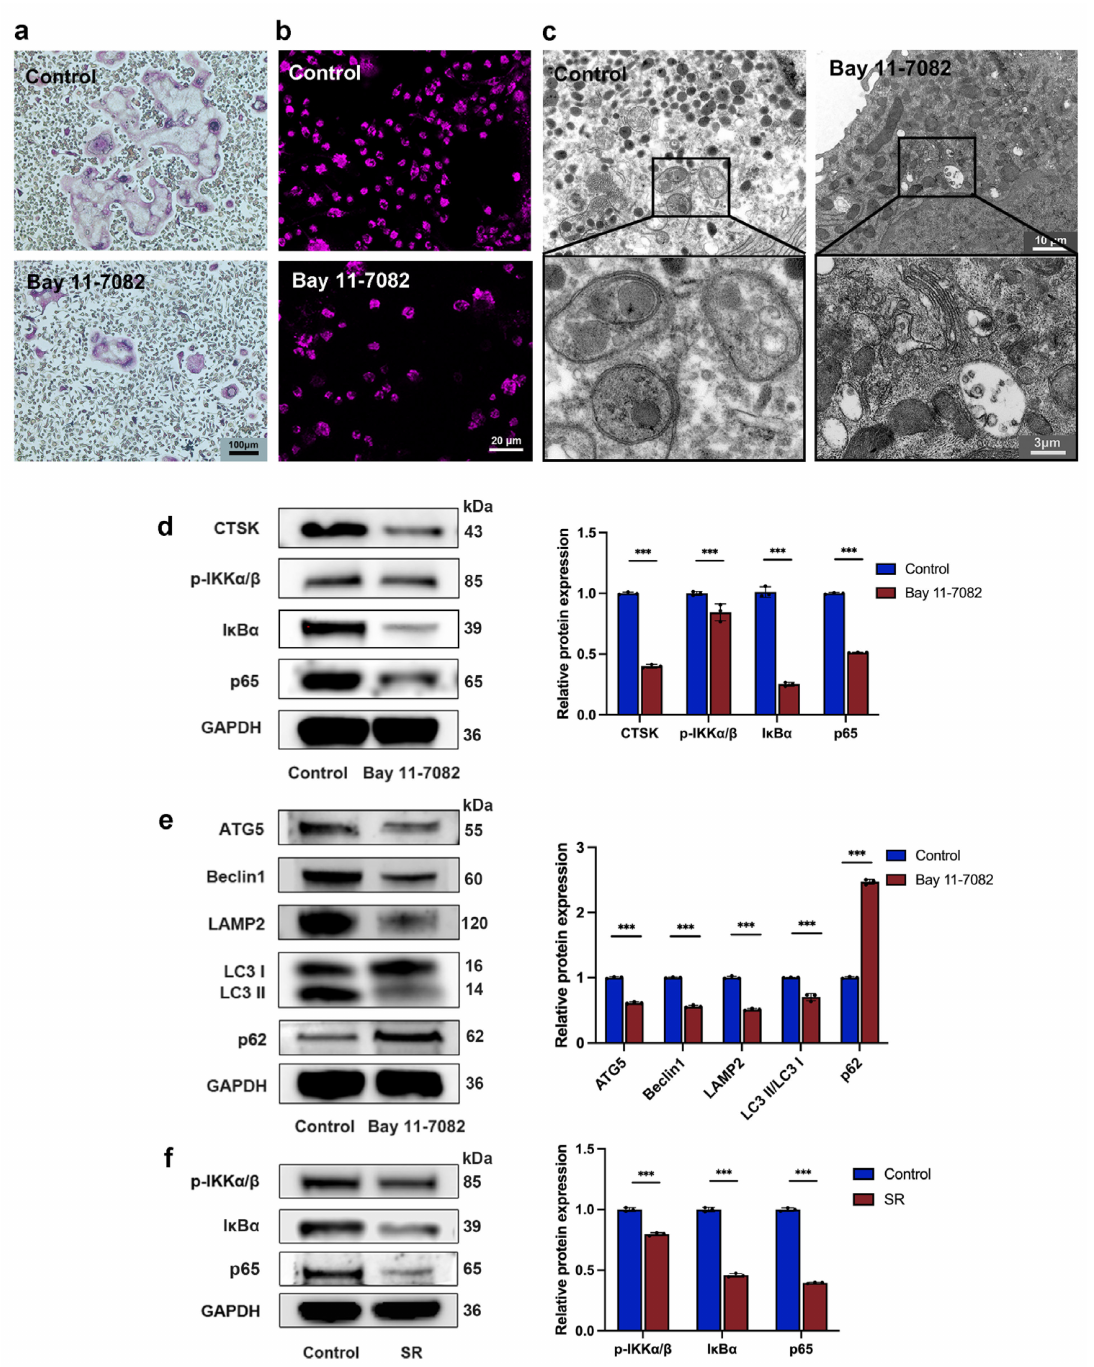
Figure 2. Strontium ranelate inhibited osteoclast differentiation through NF- κ B-pathway-dependent autophagy in vitro. ( a ) TRAP staining images after pre-osteoclasts received different treatments for 5 days. ( b ) Monodansylcadaverine staining images after pre-osteoclasts received different treatments for 5 days. ( c ) Representative images of autophagosomes captured with a transmission electron microscope after pre-osteoclasts received different treatments for 5 days. Western blot assay and relative protein expression of the osteoclast marker CTSK, the proteins central to the NF- κ B pathway (p-IKK α / β , I κ B α , and p65) ( d ), and the autophagic proteins Beclin-1, ATG5, LAMP2, LC3-I, LC3-II, and p62 ( e ) after pre-osteoclasts were treated with Bay 11-7082 for 5 days. ( f ) Western blot assay and relative protein expression of the proteins central to the NF- κ B pathway after pre-osteoclasts were treated with SR for 5 days. (n = 3, mean ± SD, *** p <